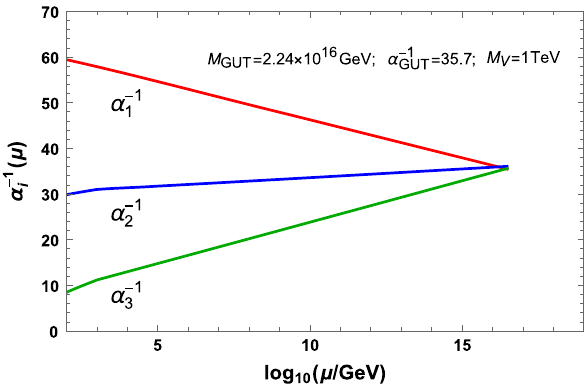
Fig. 1 Two-loop gauge coupling evaluation